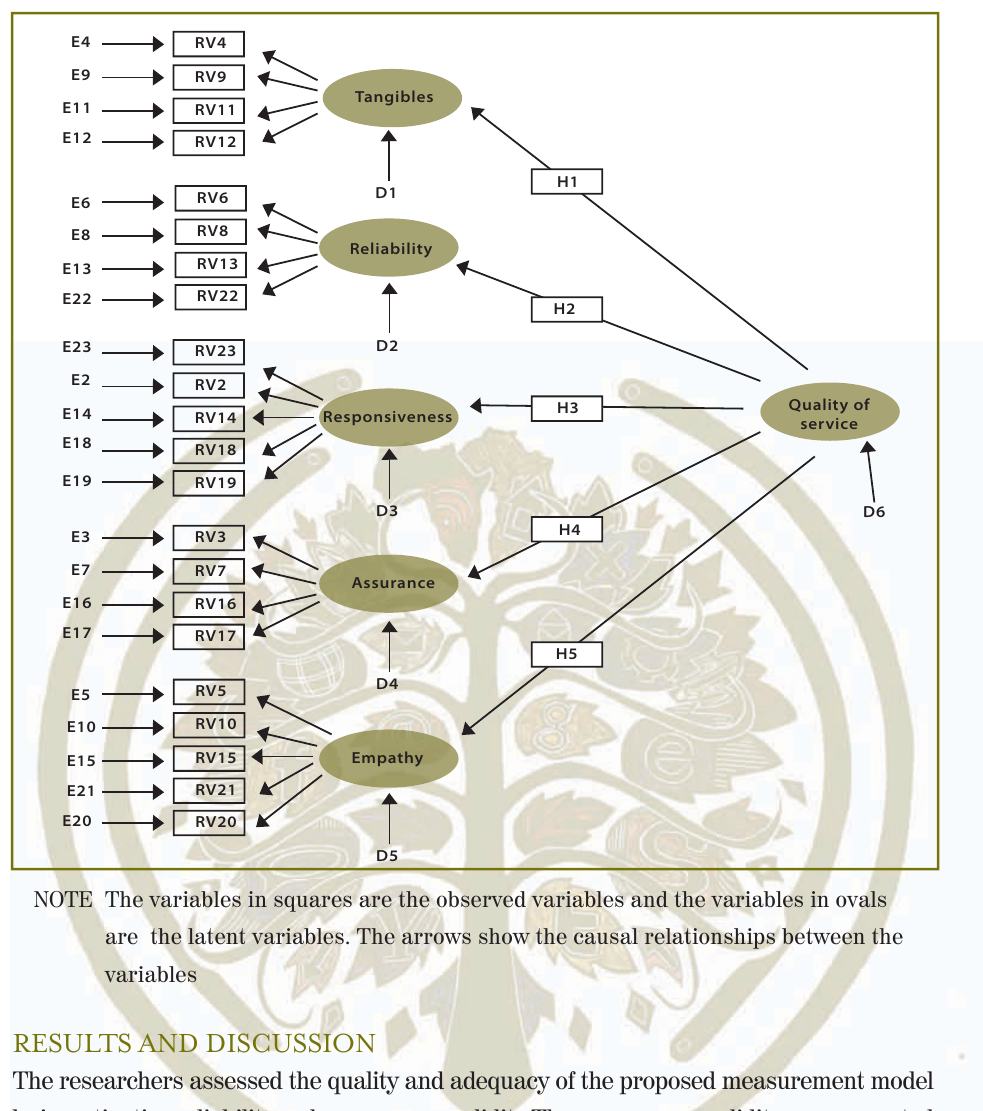
FIGURE 2 THE HYPOTHESIZED STRUCTURAL EQUATION MODEL